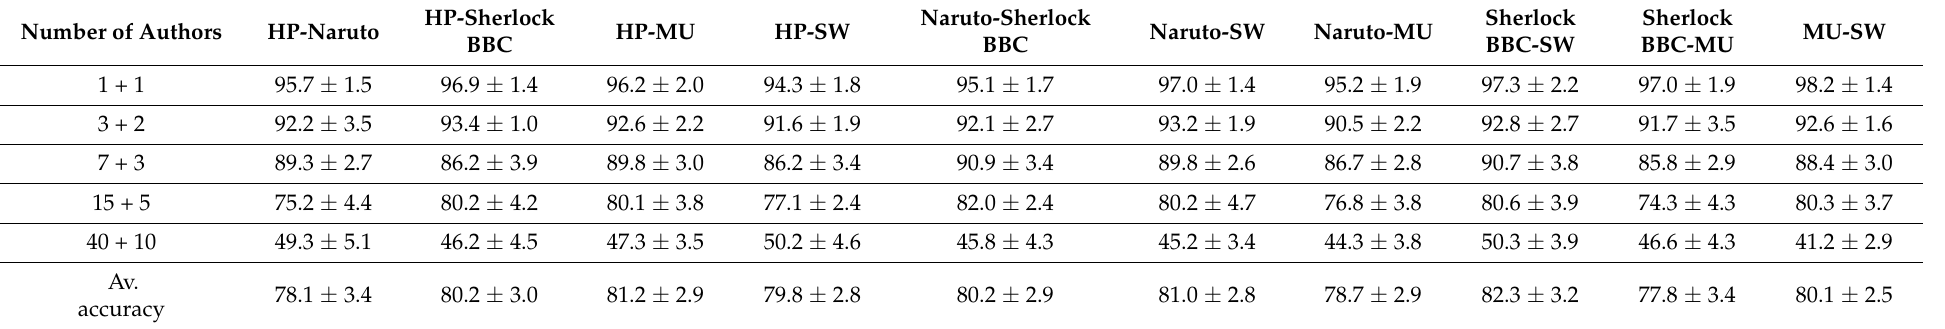
Table 12. Method based on Euclidean distance for cross-topic case.